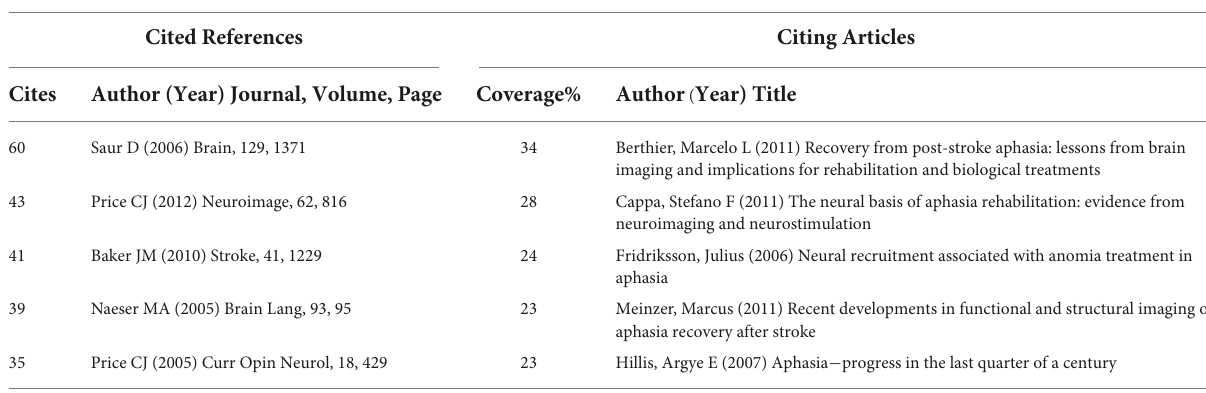
TABLE 8 Cited references and citing articles of Cluster #4 on aphasia